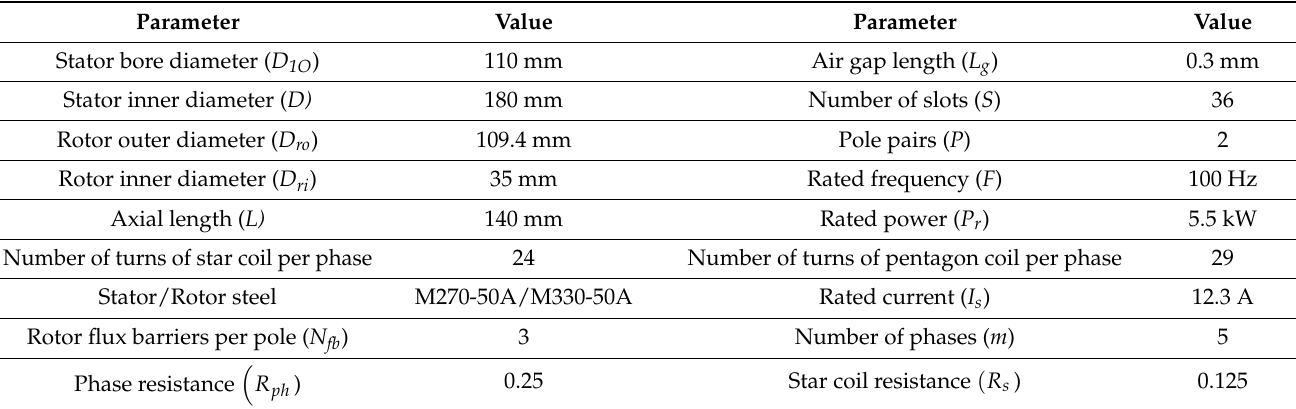
Table 1. The five-phase SynRM geometrical